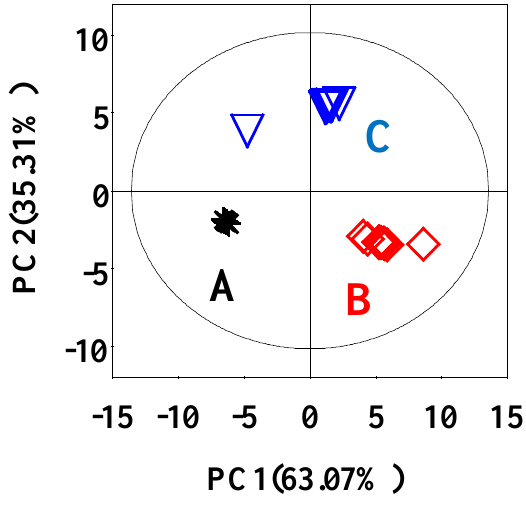
Figure 2. PCA score plots for SPHSS ( A ), SPH ( B ) and MRPH ( C ). PC1 and PC2 represent 63.07% and 35.31% of the total variance, respectively.